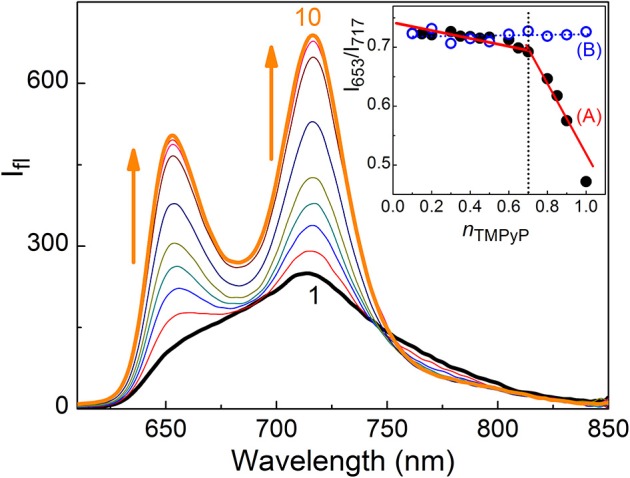
Fluorescence spectra of 2.1 μM TMPyP with captisol in H2O, λexc = 435 nm. [captisol]/μM: (1) 0.0, (2) 0.25, (3) 0.5, (4) 0.75, (5) 1.0, (6) 1.5, (7) 3.5, (8) 7.0, (9) 14.8, and (10) 22.0 at pH ~7.4. Inset shows Jobs plot using the fluorescence intensity ratio (I717/I653) with mole fraction of TMPyP, nTMPyP, for the Captisol:TMPyP complex (A), where [captisol] + [TMPyP] = 10 μM, and only TMPyP solution (B) under identical concentration conditions.